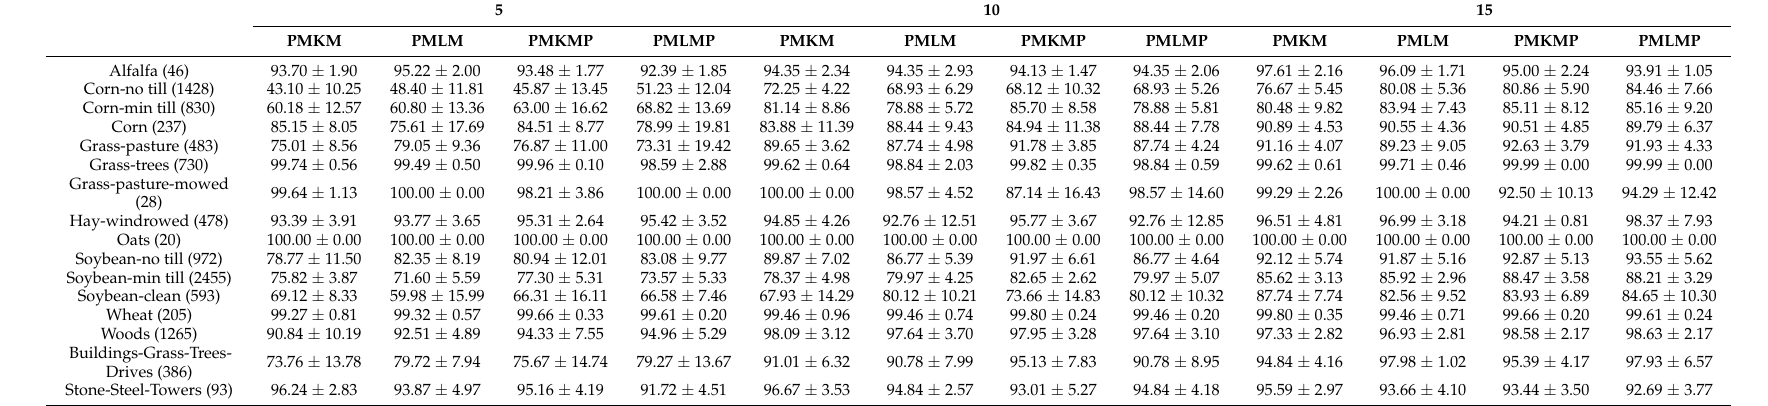
Table 2. Classification accuracy over overall accuracy (OA (%)) and standard deviations for each class in the Indian Pines dataset.